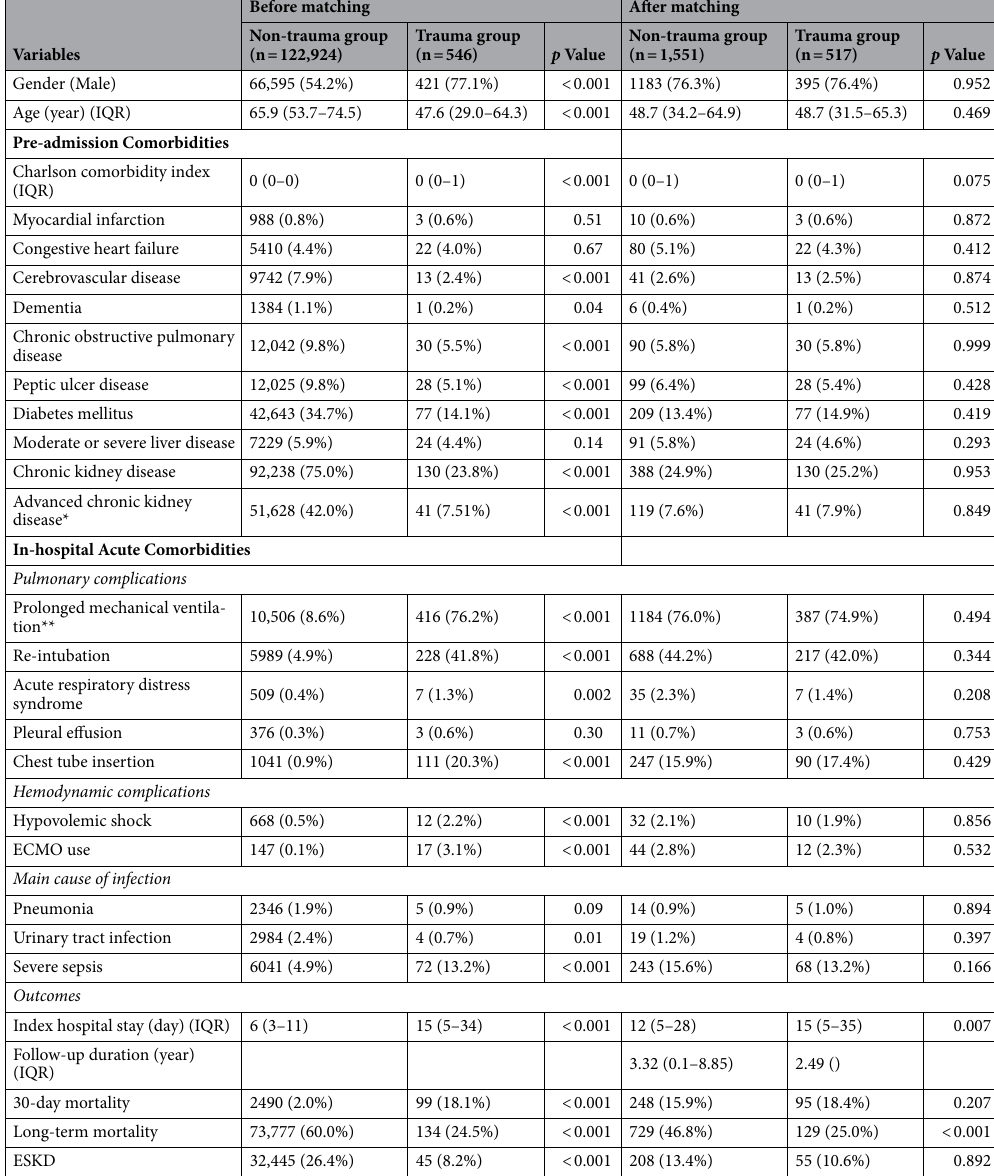
Table 1. Clinical characteristics after propensity score matching (NHIR database). ECMO, extracorporeal membrane oxygenation; ESKD, end stage kidney disease; IQR, interquartile range. *Advanced chronic kidney disease: presence of CKD coding and concomitant reimbursement coding of erythropoiesis-stimulating agents without copayment. **Prolonged mechanical ventilation: the use of mechanical ventilation ≥ 21